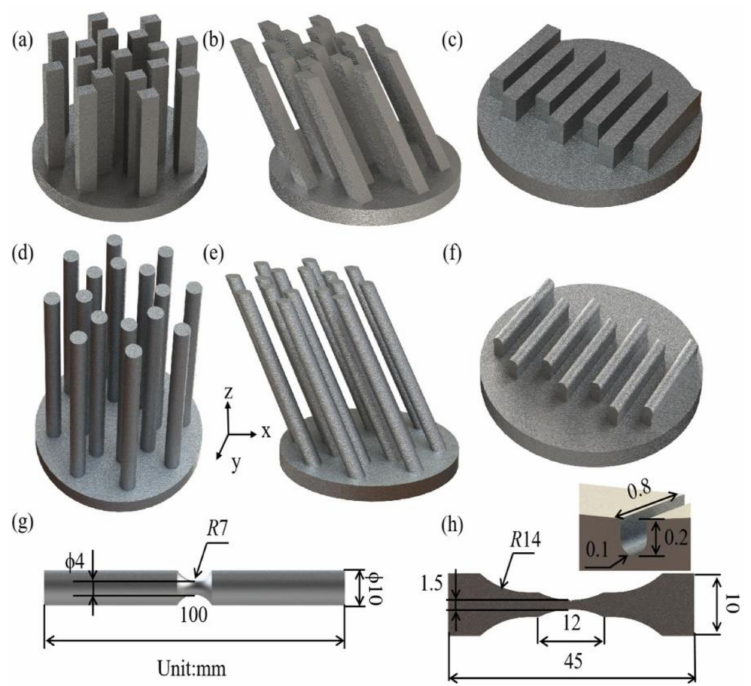
Figure 8. In-situ fatigue and RBF samples: ( a , d ) 90 ◦ samples; ( b , e ) 45 ◦ samples; ( c , f ) 0 ◦ samples; ( g , h ) geometries of RBF bar and in-situ fatigue samples. Reprinted with permission from ref. [67]. 2021,